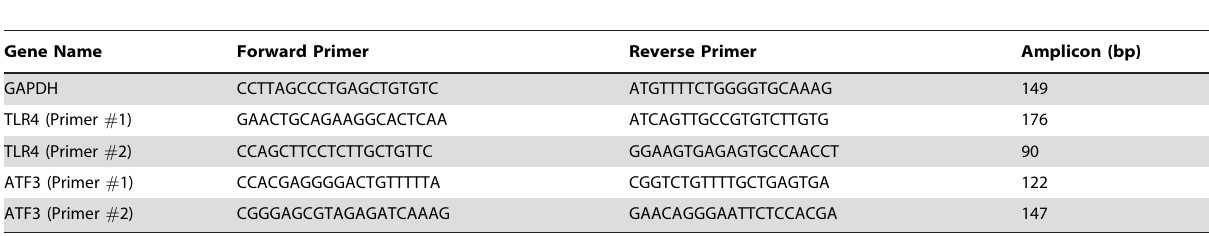
Table 3. ChIP-qPCR primer sequences and expected amplicon